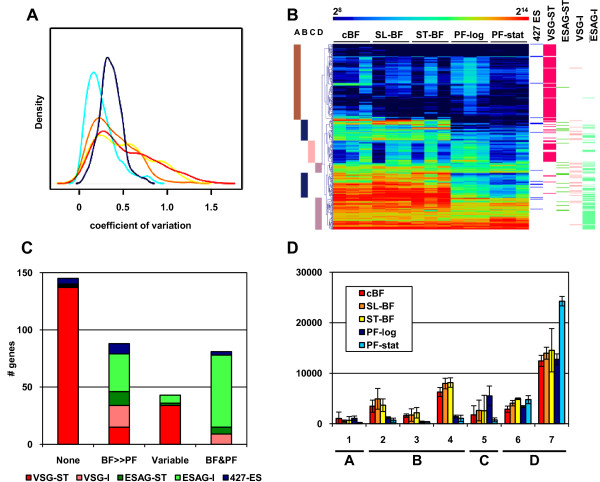
Cluster analysis of ESAG and VSG gene expression. A. Signals from probes detecting VSG/VR genes. Density plot of gene-level coefficient of variation for VSG genes, defined as the standard deviation across the three biological replicates divided by the mean value of the replicates. The lines are cBF (red), slender BF (orange), stumpy BF (yellow), PF-log (dark blue), and PF-stationary (light blue). B. Heatmap of the ESAG/GRESAG and VSG/VR genes after hierarchical clustering of the individual sample log2-transformed raw expression values. The clusters were pooled into four different expression patterns as shown on left. At right the genomic location of genes is shown: 427-ES, those detected by probe-sets corresponding to sequenced 427 strain VSG expression sites; I, chromosome internal; ST, sub-telomeric as defined by occurring distal to the first or last strand-switch region on the chromosome. C. Representation of each gene class in the four clusters, classified as either sub-telomeric (VSG-ST, ESAG-ST) or chromosome internal (ESAG-I, VSG-I). Some of the genes derived from the 427 ESs last are likely not present in strain 927, while the remainder reside in regions not sequenced in strain 927 such as the intermediate or minichromosomes and the telomeres. D. Examples of VSG/VR genes from the four groups. The mean and standard deviation of the individual samples in each biological condition is shown. Genes are: group A (1, VSG Tb11.57.0024), group B (2, VSG Tb09.v4.0012, 3, VR10 Tb927.5.110, 4, VR16 Tb09.v1.0300), group C (5, unclassified VSG Tb05.5K5.440), and group D (6, atypical VSG Tb927.4.5400, 7, VR Tb927.5.291b).